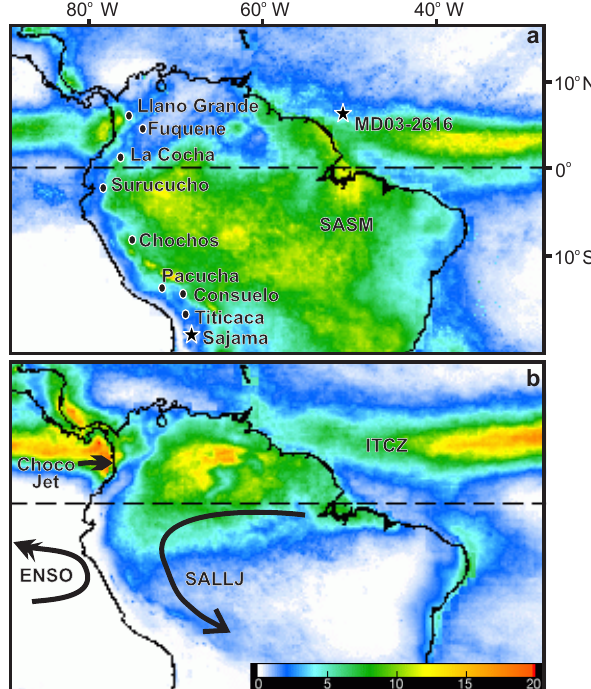
Figure 1. Average daily rainfall rates during the months of Jan- uary (a) and July (b) from 1998 to 2007 from the Tropical Rain- fall Measuring Mission. Black circles show the locations of pollen records described in Table 1. Stars indicate the location of the sea surface temperature record from the tropical Atlantic (MD03-2616) and the Sajama ice core. The rainfall distribution depicts the av- erage southern (a) and northern (b) positions of the Intertropical Convergence Zone (ITCZ) and the South American summer mon- soon (SASM). Arrows indicate the approximate location of rele- vant atmospheric and oceanic systems: South America low-level jet (SALLJ), El Niño–Southern Oscillation (ENSO), and the Chocó